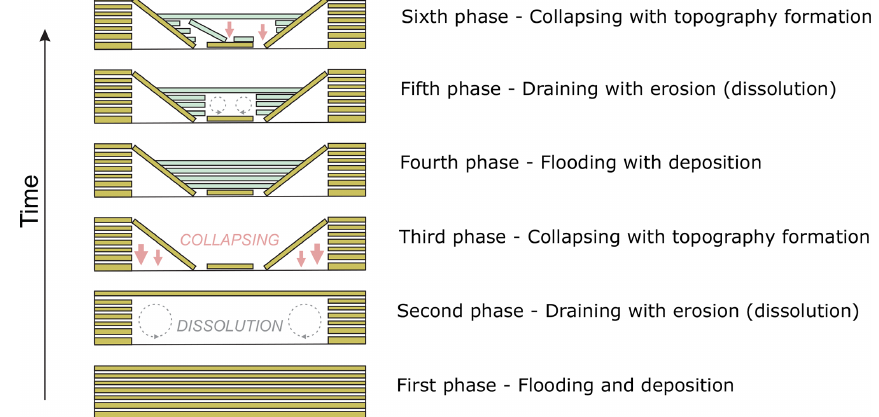
Figure 14. Steno’s evolutionary diagram describes six stages for the geologic history of Tuscany, including flooding cycles and crustal collapse (modified from Kravitz,